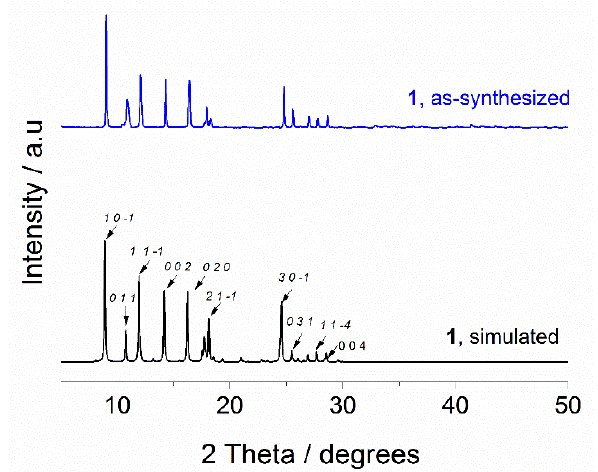
Figure 4. Indexed PXRD simulated pattern and measured pattern of 1 at room temperature.